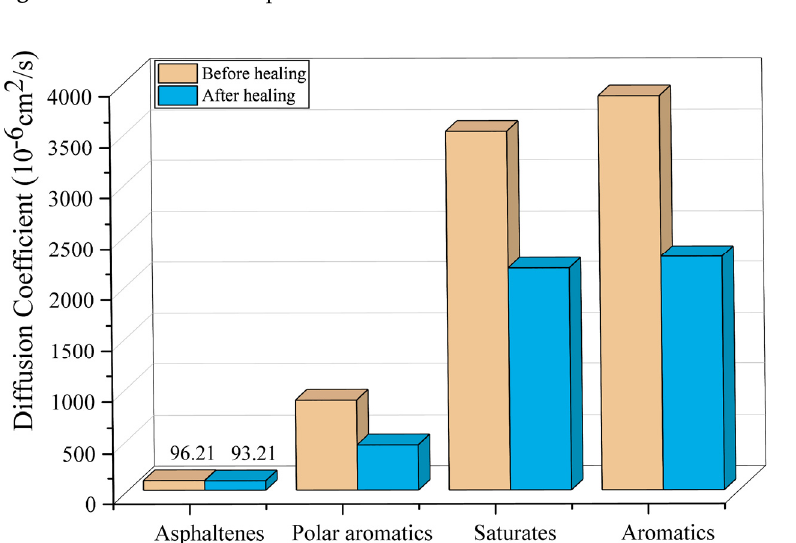
Figure 9. Diffusion coefficient of each component before and after healing.